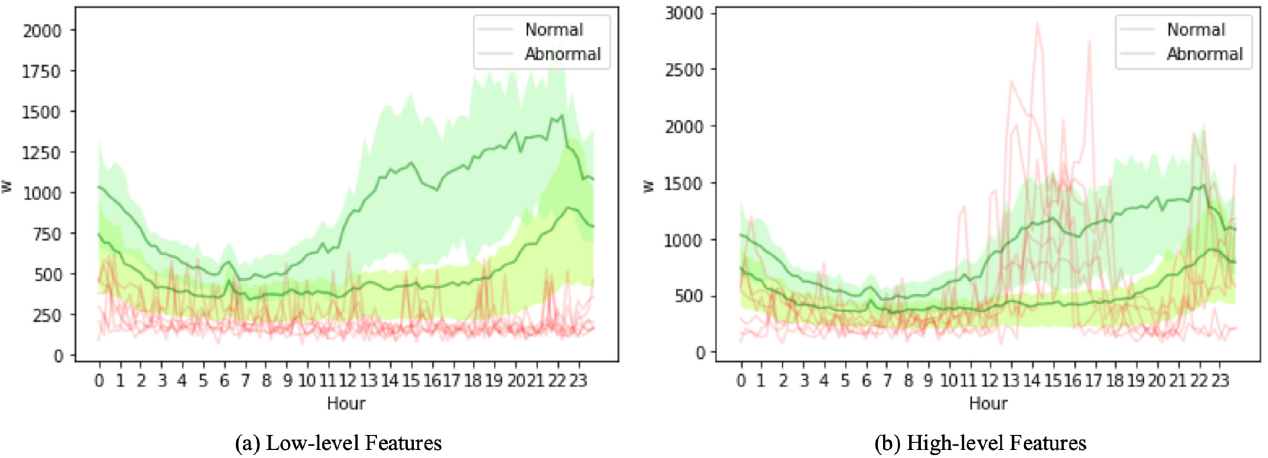
Figure 6. Load profiles of the main and abnormal electricity consumption events of User 02.